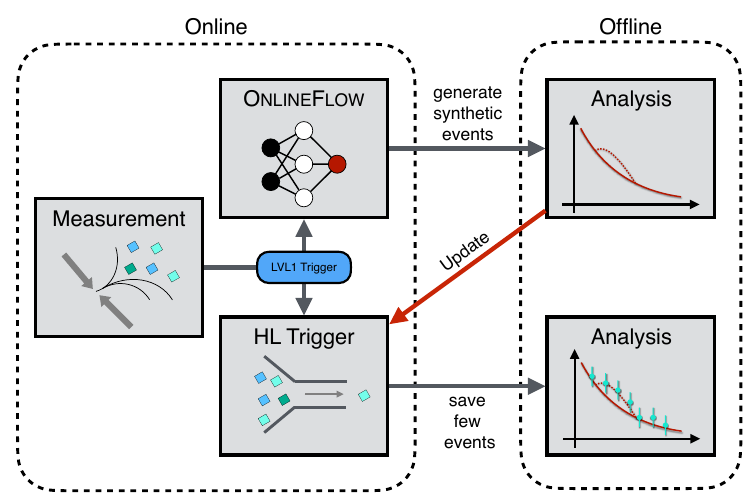
Figure 2: Illustration of the proposed workflow. First, we train a generative model on all incoming events (online). Then, we use the trained model to generate data